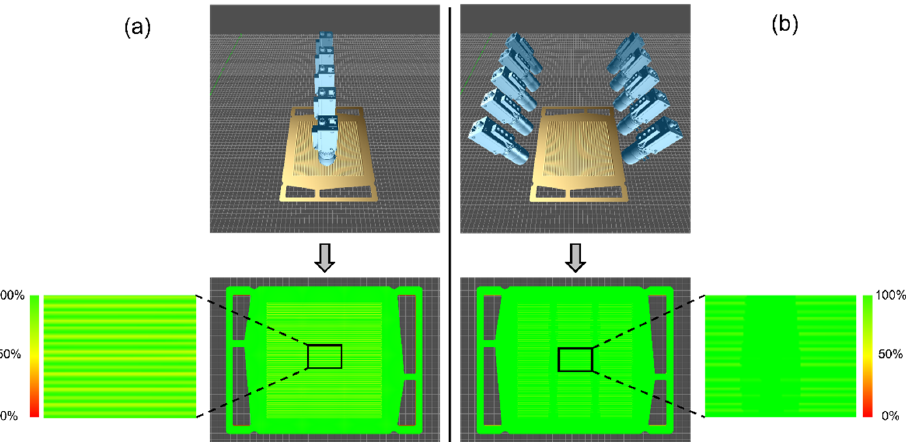
Figure 6. Two different camera configurations and the result of their coverage simulation: ( a ). or- thogonal model with a camera tilt angle of 90° and ( b ) V-model with a camera tilt angle of 60°.